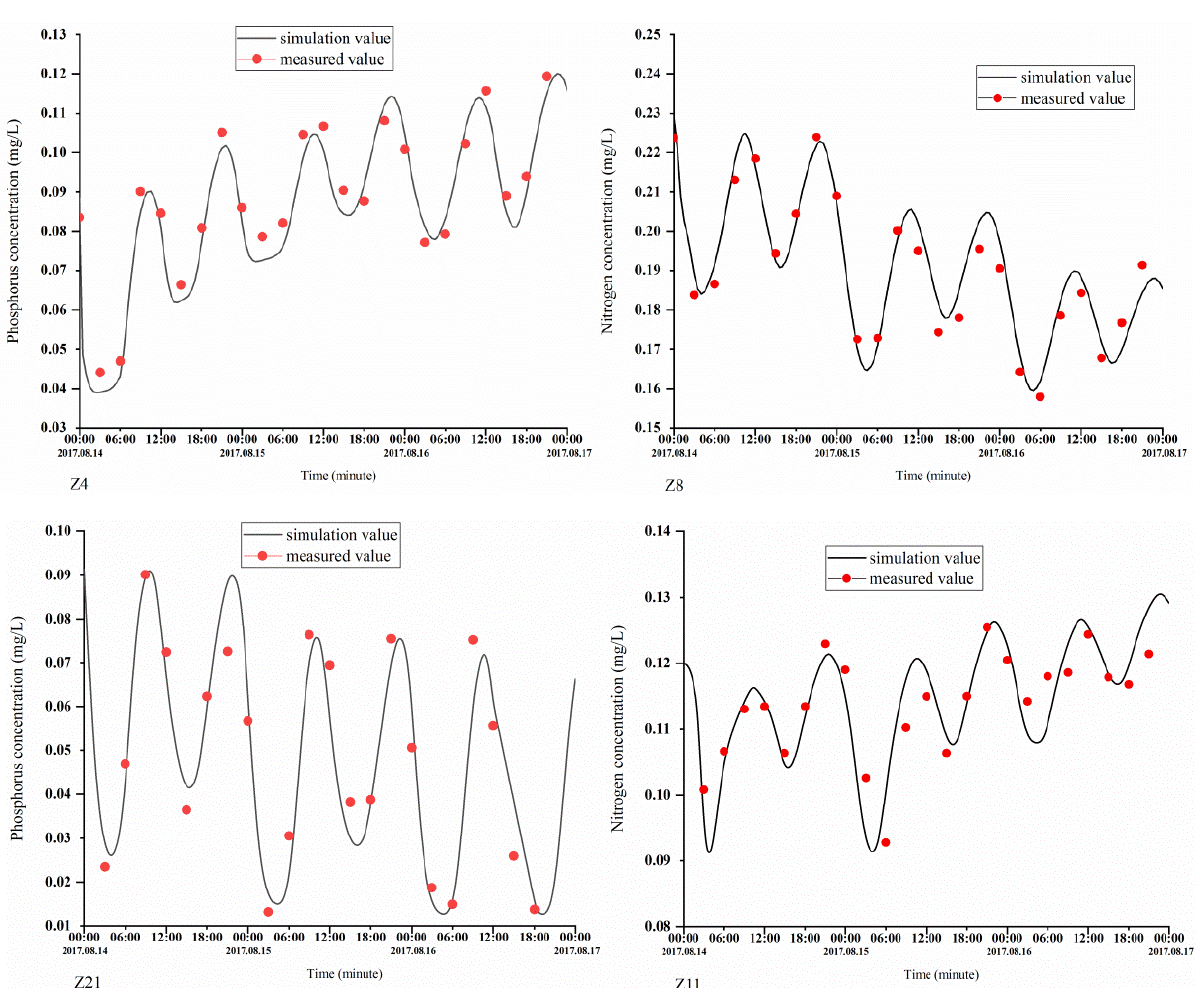
Figure 6. Validation of the phosphorus concentrations at the Z4 and Z21 stations and nitrogen concentrations at the Z8 and Z11 stations.